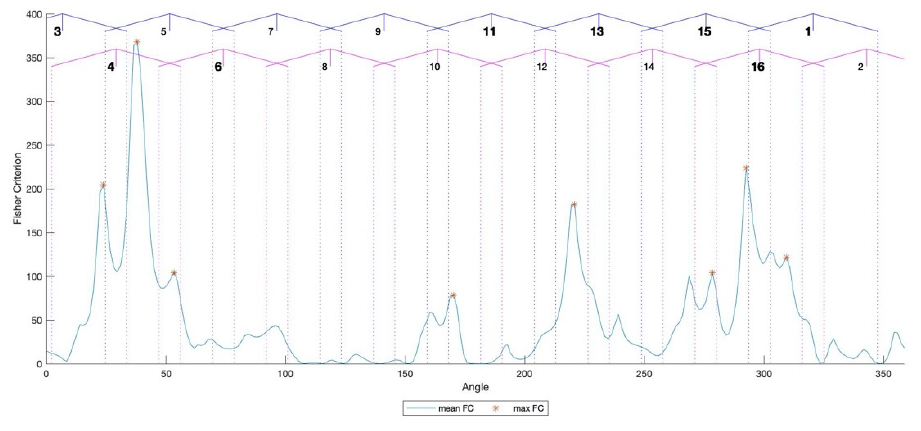
Figure 8. The Fisher criterion for the